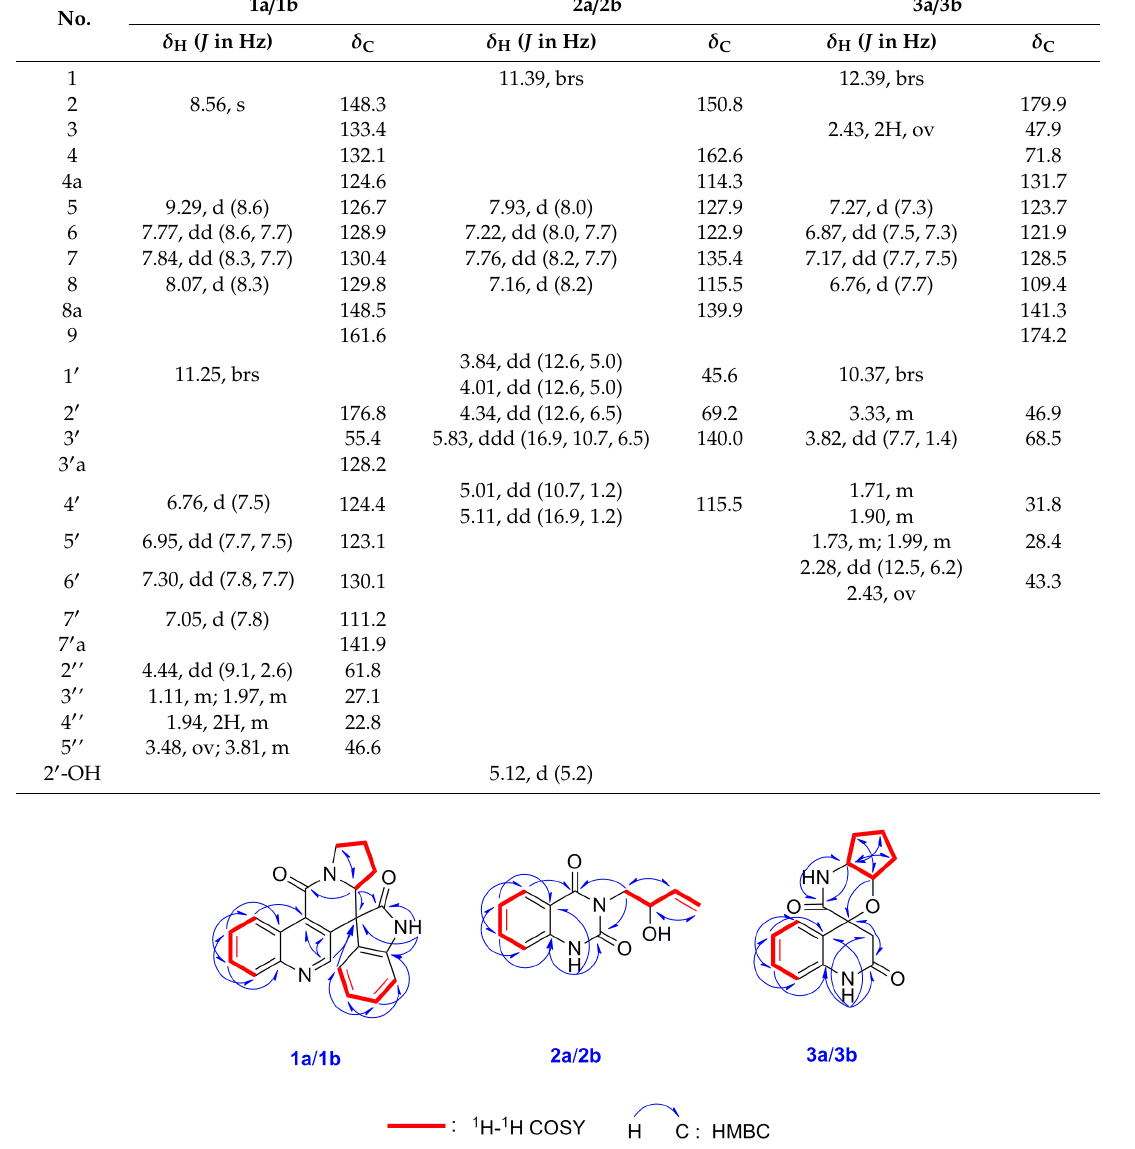
Figure 2. Key 1 H- 1 H COSY and HMBC correlations of compounds 1a/1b – 3a/3b. Table 1. 1 H NMR (600 MHz in DMSO- d 6 ) and 13 C NMR data (150 MHz in DMSO- d 6 ) of 1a/1b – 3a/3b (ov: overlap signals).